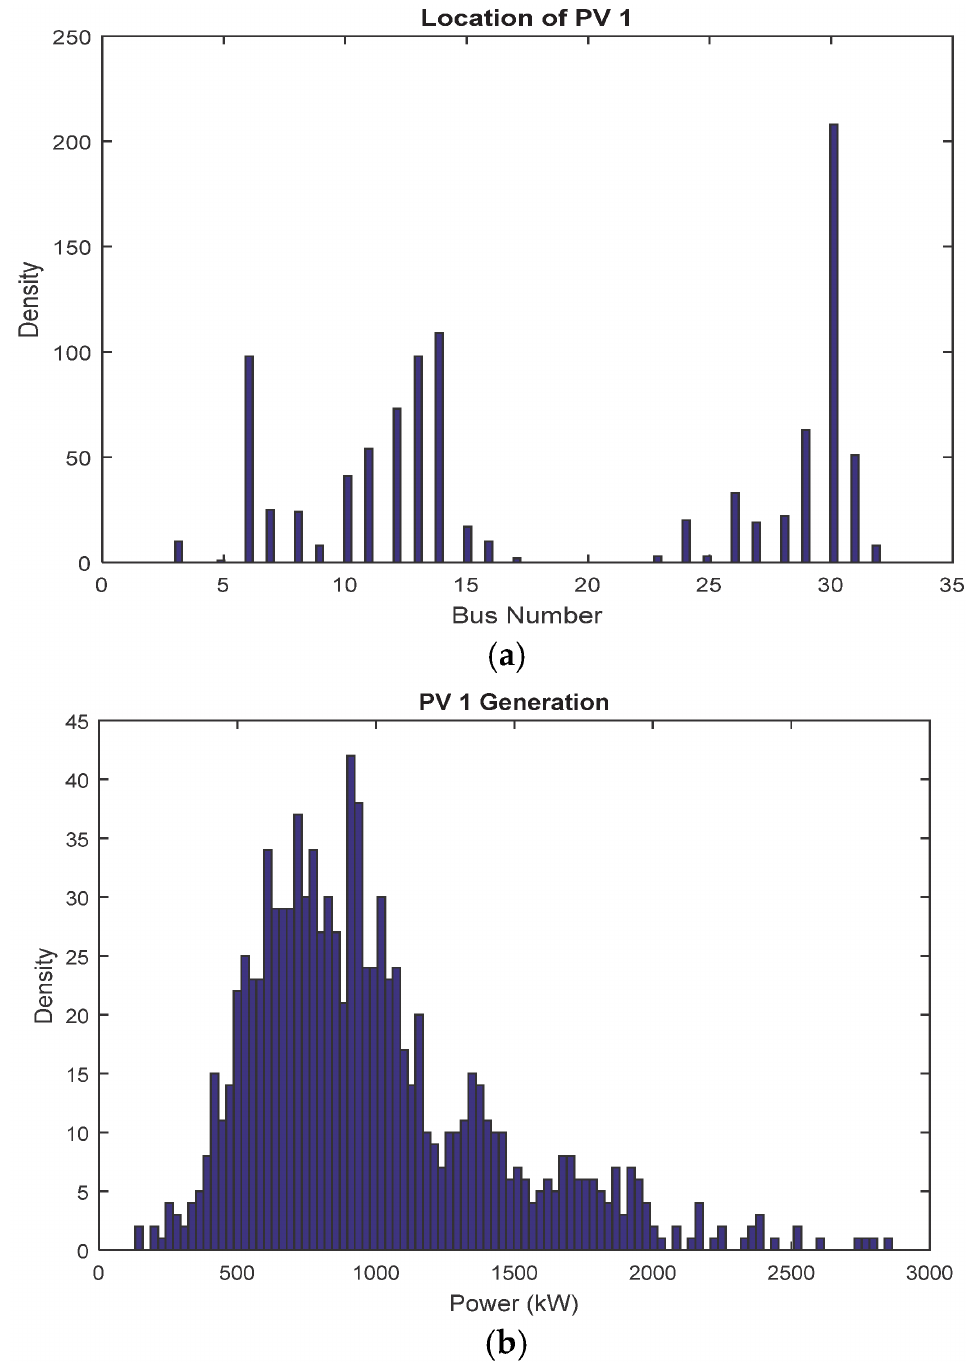
Figure 13. The PDF of placement and size of 1st PV in the 33-bus system with uncertainties using IHLOA: ( a ) location of 1st PV; ( b ) 1st PV